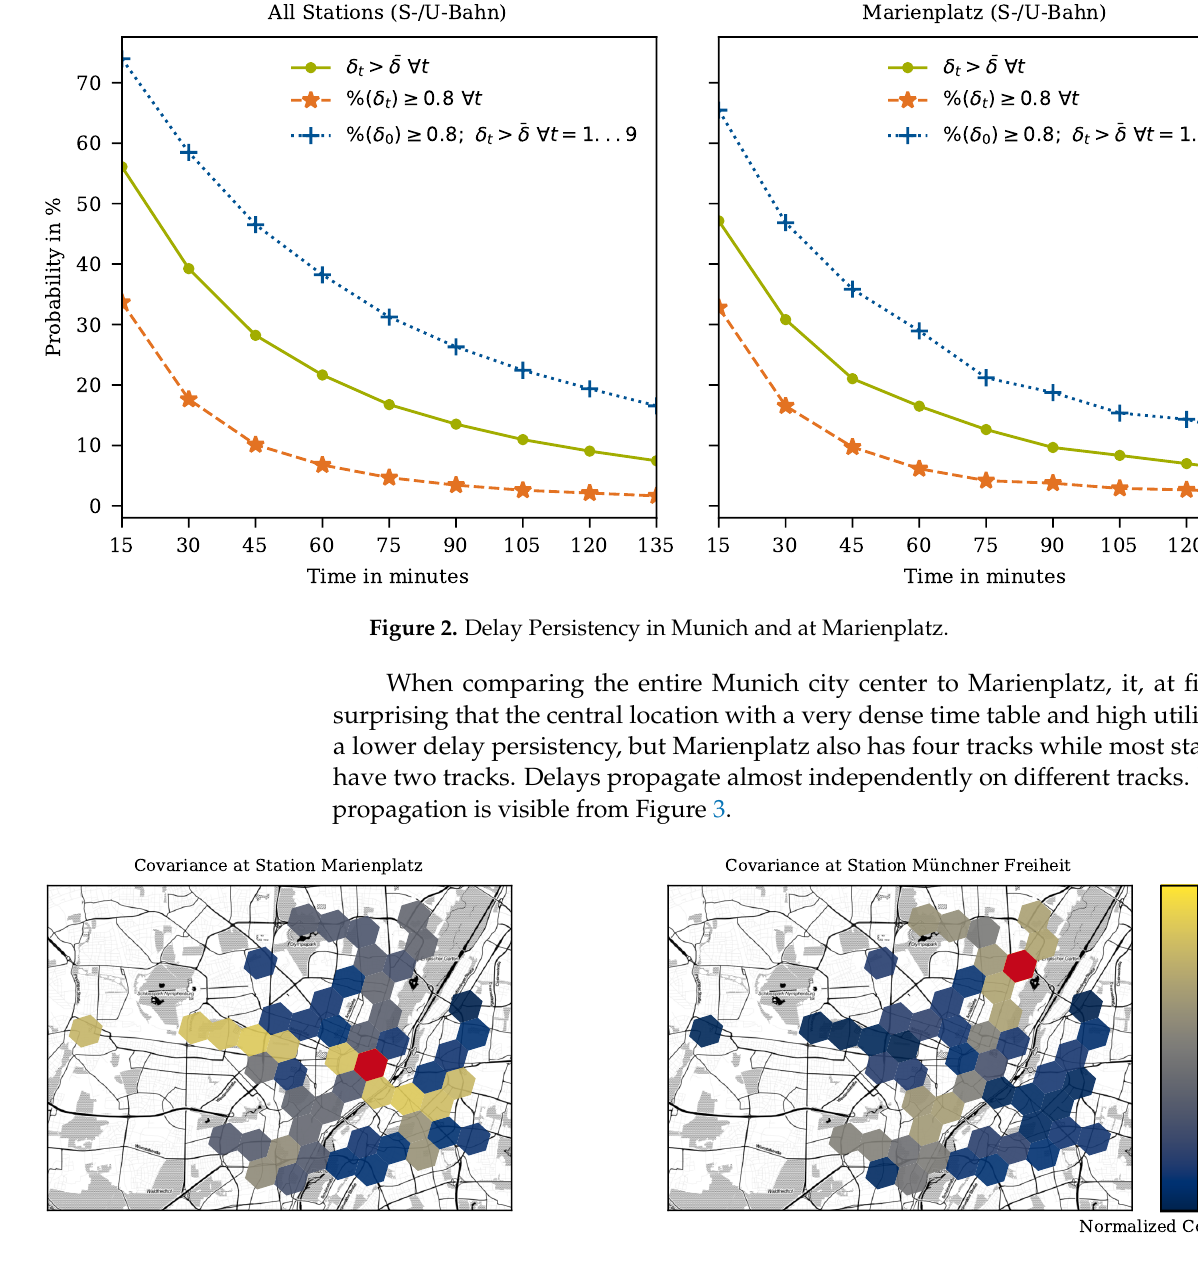
Figure 3. Delay Propagation in the Public Transit Network. It shows the probability that an above average delay at Marienplatz (left) or Münchner Freiheit (right) correlates with an above average delays at other stations. Yellow shading refers to a high covariance, blue shading to a low covariance. Clearly, stations along the same line have a higher probability of delays and, at Marienplatz, this mainly